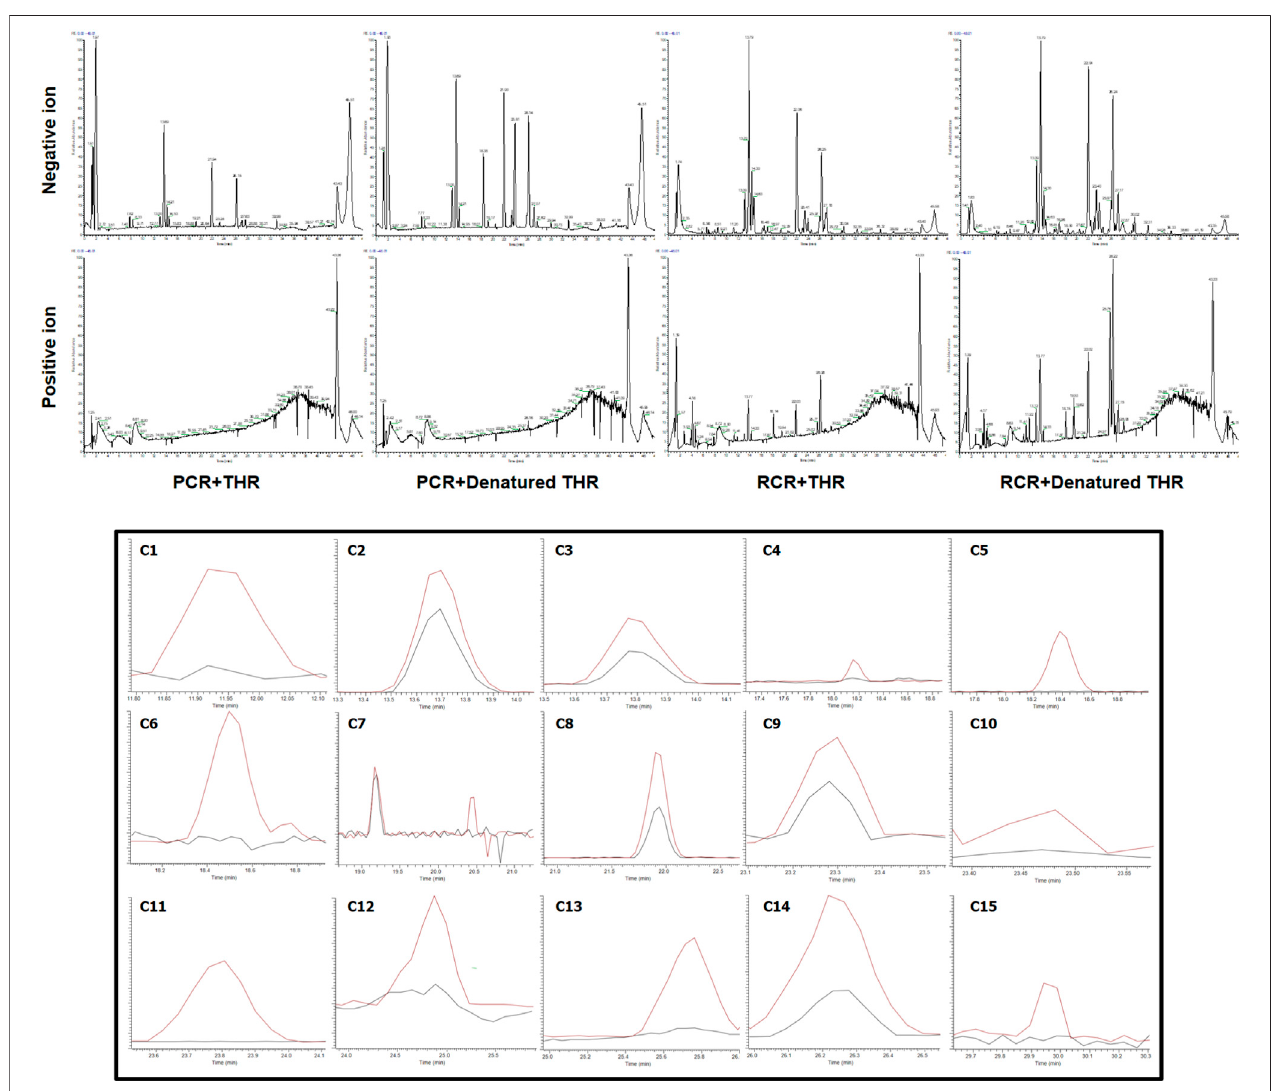
FIGURE 1 | Selective ion monitoring chromatograms for screening potential THR inhibitors by combined use of af fi nity ultra fi ltration and high-performance liquid chromatography-mass spectrometry (AUF-LC-MS). (Black line, experimental group with active enzyme; red line, control group with denatured enzyme).